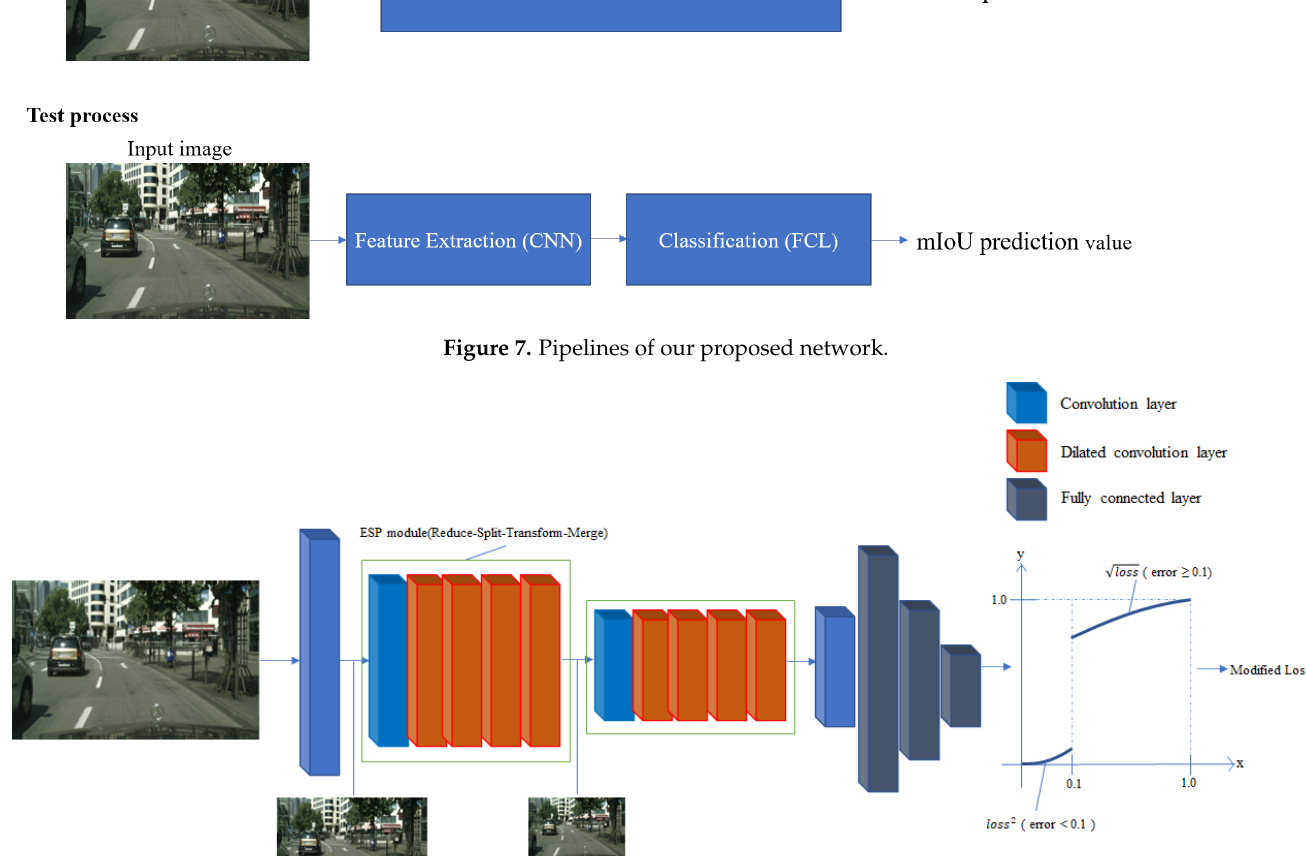
Figure 8. Overall architecture of our proposed